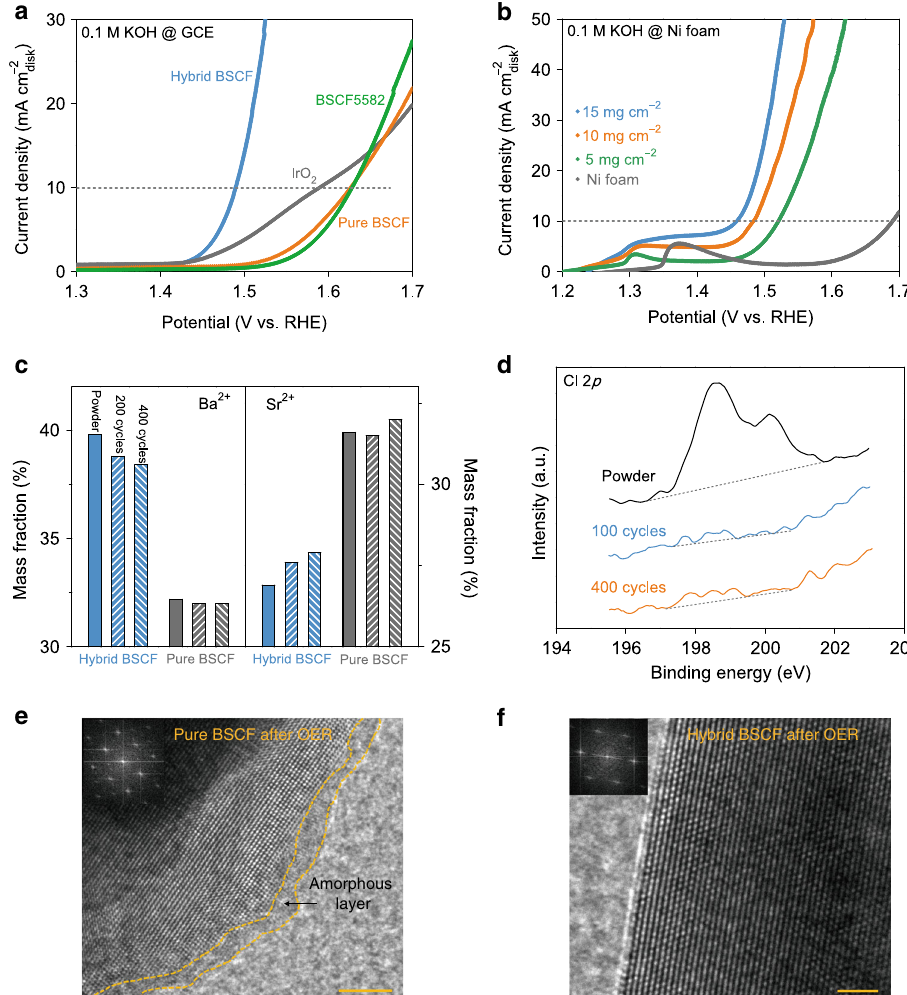
Fig. 3 Electrocatalytic OER performance and ion leaching behaviors. a OER activities of hybrid BSCF, pure BSCF, BSCF5582, and IrO 2 catalysts measured on GCE in 0.1 M KOH at 25 °C. b OER performance of hybrid BSCF with different catalyst loadings tested on nickel foam. c ICP-MS results of Ba 2 + and Sr 2 + ions in pristine powders and CV-activated samples. d Cl 2 p XPS spectra of hybrid BSCF before and after CV activations. HRTEM images of e pure BSCF after OER (scale bar is 5 nm) and f hybrid BSCF after OER (scale bar is 2 nm). Inset fi gures are the corresponding FFT patters of respective crystalline